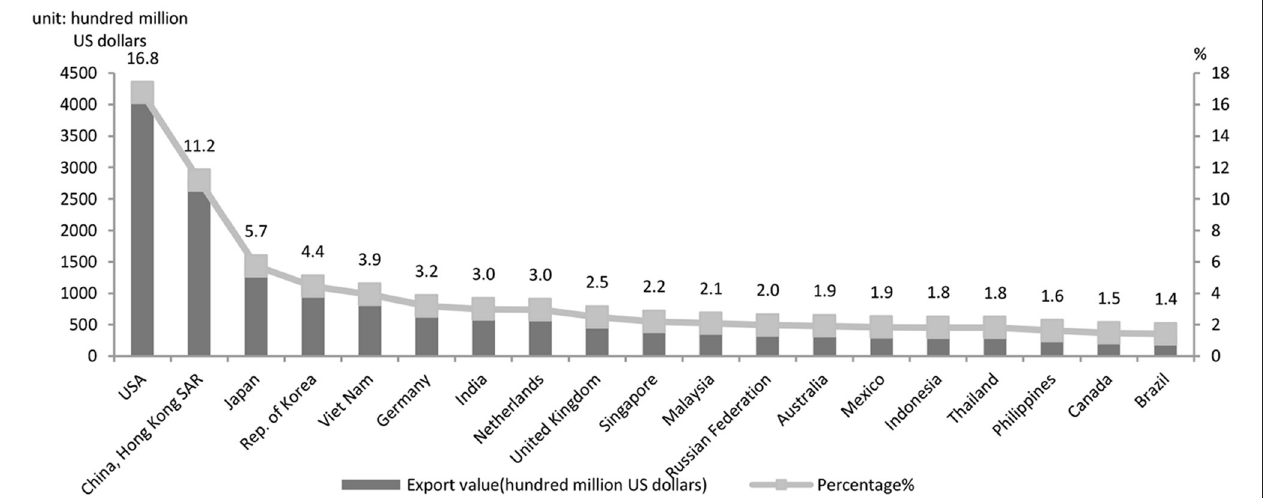
FIGURE 2 | China’s export partners in 2019. Data source: WITS.